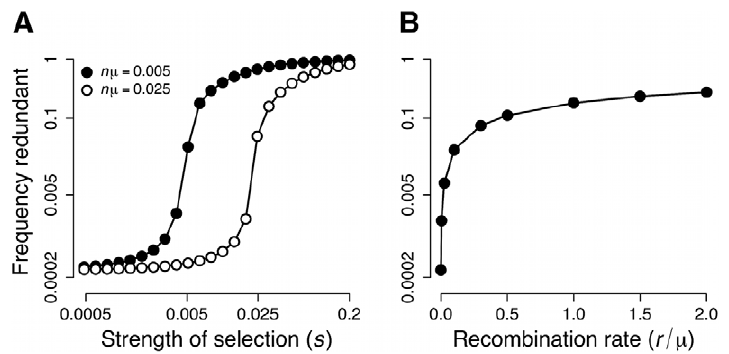
Figure 4. Effects of selection for multiplicity and recombination on the evolution of redundant cis -regulation. Each effect was added separately to the model shown in Figure 3. Values are the total frequencies of the redundant genotype (0,0) at equilibrium under different scenarios. (A) Direct selection for multiplicity (partial redundancy) under different mutation rates, m . (B) Recombination rate between binding sites, r . The equilibrium distribution is invariant for a given r = m , but it is reached more quickly for higher values of m .